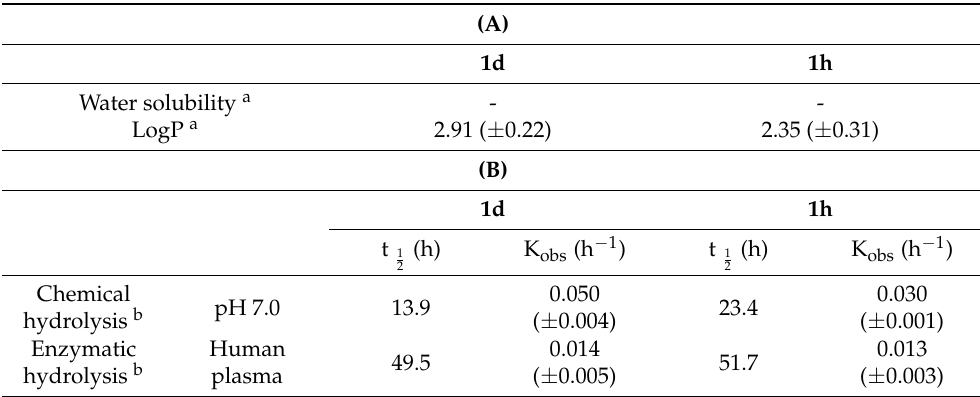
Table 1. ( A ) Physicochemical properties of 1d and 1h ; ( B ) chemical and enzymatic stabilities of 1d and 1h . t 1/2 refers to half-life expressed in hours; k obs refers to the observed constant expressed in